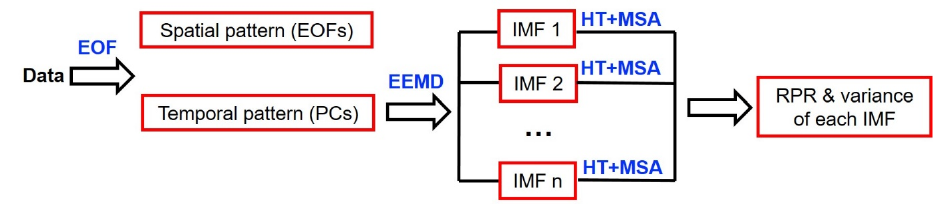
Figure 3. The flowchart of the EOF–EEMD analysis visualization package. The red boxes represent the quantities visualized.